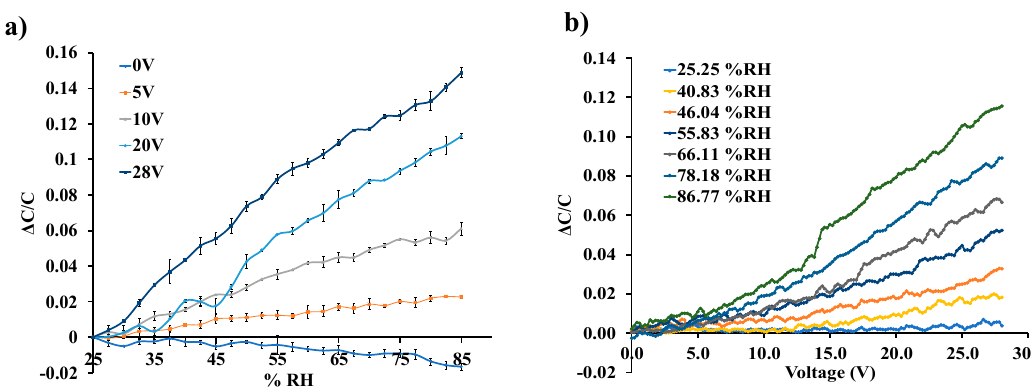
Figure 6. ( a ) Sensor response to varying %RH levels at different DC bias voltage; ( b ) sensor response to a varying bias voltage at different %RH levels.